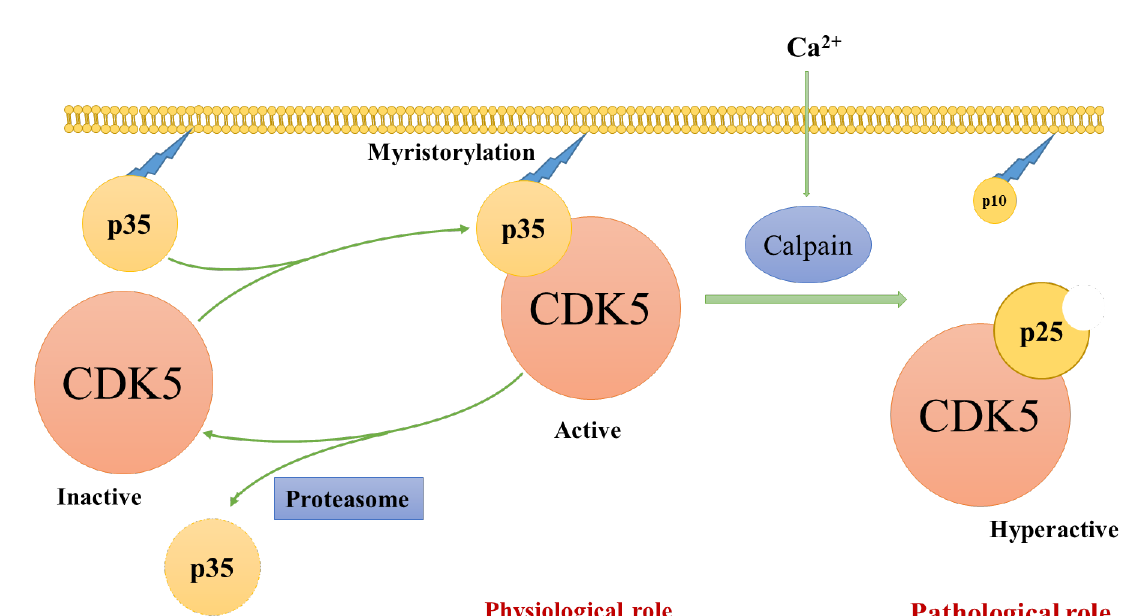
Figure 1. The mechanism of Cdk5 activation. The mechanism of Cdk5 activation. CDK5 alone is an inert catalyst subunit. CDK5 is activated by the p35 CDK5 activator and moves to the membrane as p35 binds to the membrane through myristoylation of the N-terminal region. p35 is a short-lived protein that is broken down by proteasomes. When cells are stressed or met with death signal, calpain is activated and cuts p35 into p25 C-terminal fragments. The deletion of p10 prolongs the half-life of p25. CDK5/p25 can be separate from the membrane and phosphorylate additional proteins. (modified from Kimura et al. [46] ).